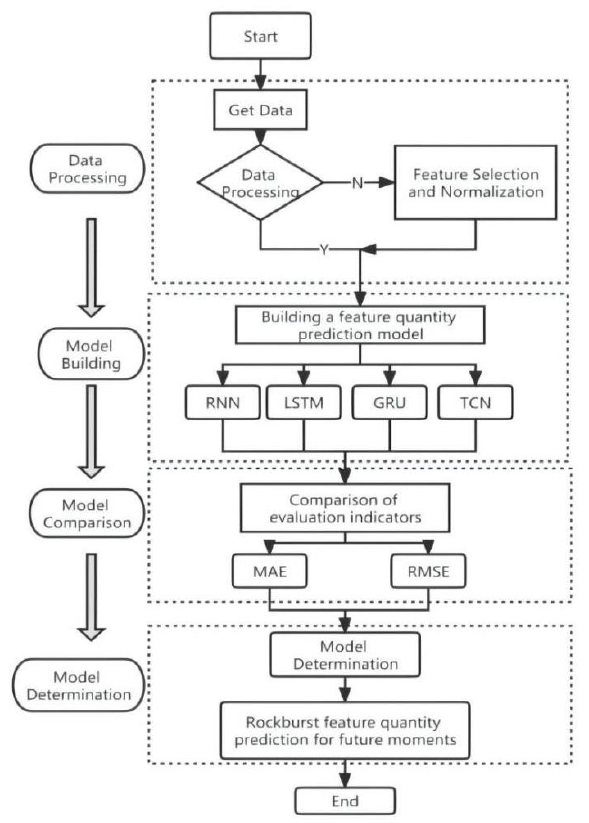
Figure 3. Building process of rockburst characteristic variables prediction model. (cid:172) Sample data processing. The missing values and outliers of the dataset are filled